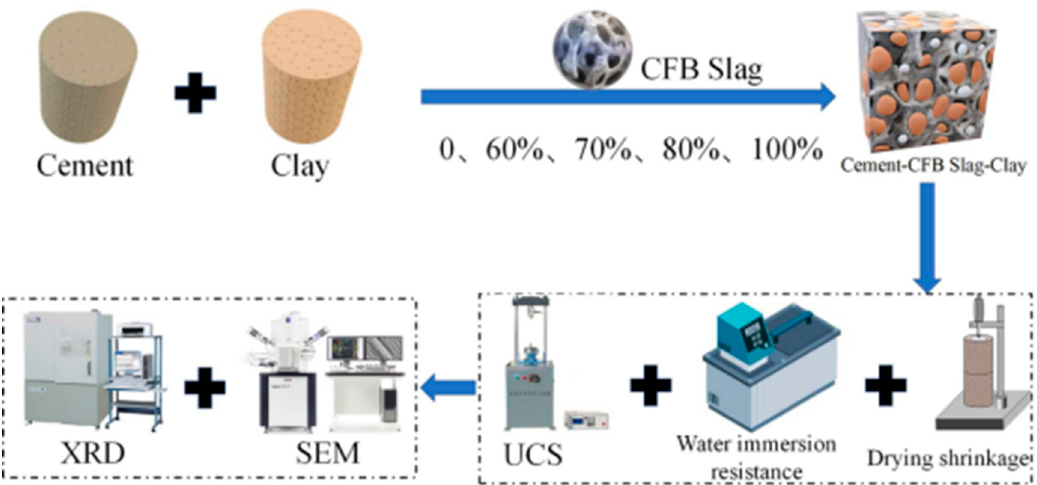
Figure 3. Experimental process